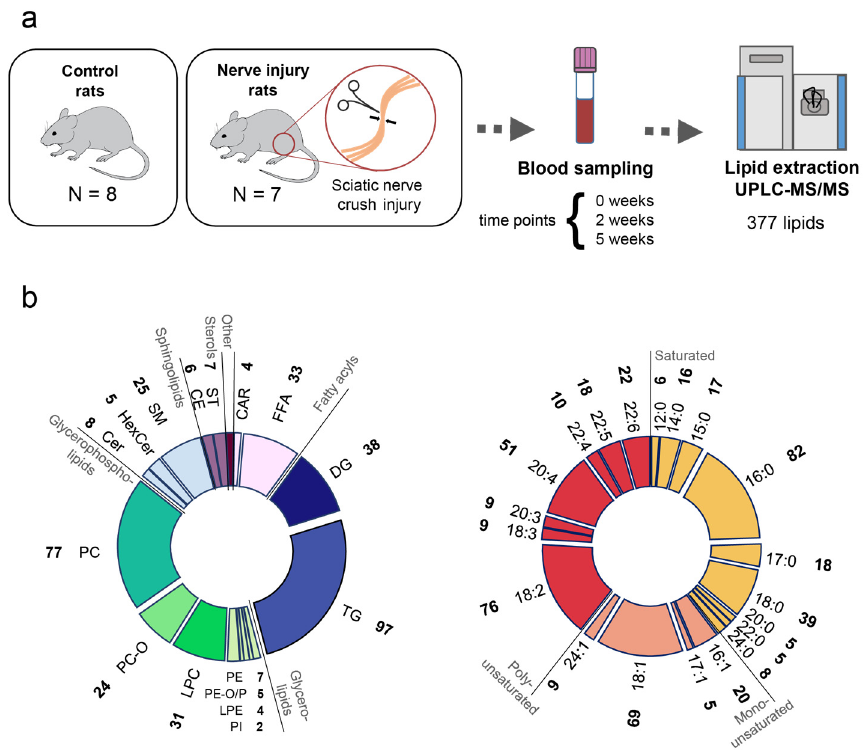
Figure 1. Blood lipidomics of nerve injury. ( a ) Schema of experimental design. ( b ) Distribution of quantified lipids by class (left) or fatty acid residue (right). The number of lipids in each lipid class or the number of particular fatty acid residues is indicated next to the corresponding shorthand